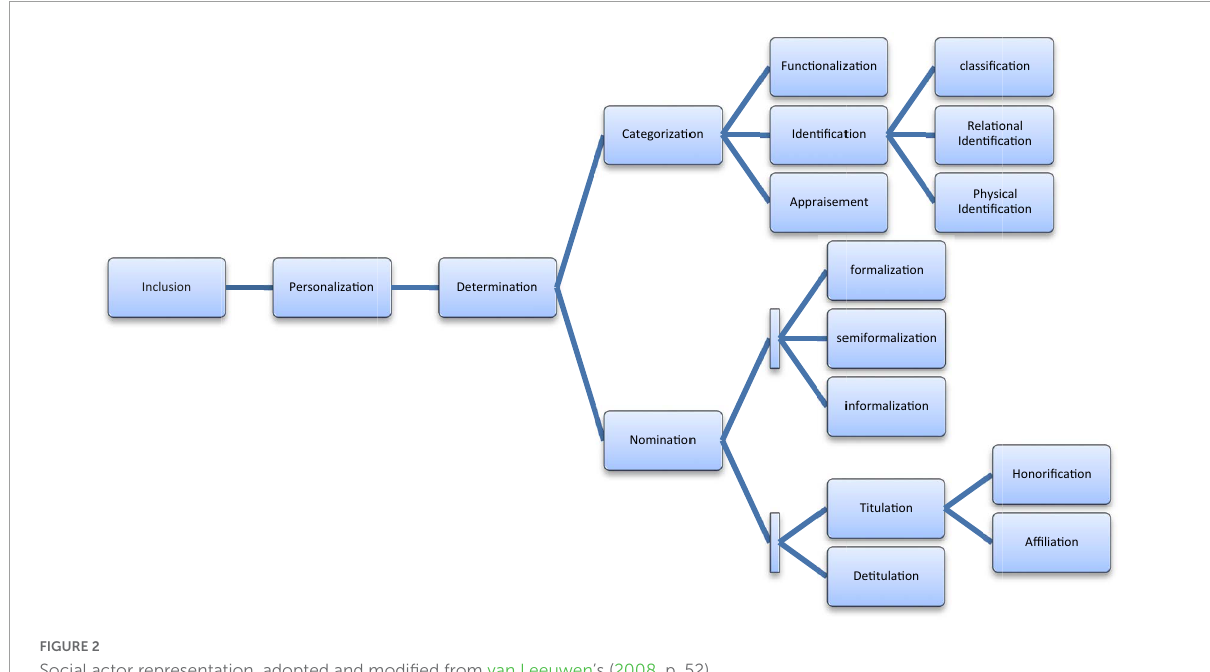
FIGURE2 Social actor representation, adopted and modified from van Leeuwen’s (2008, p.